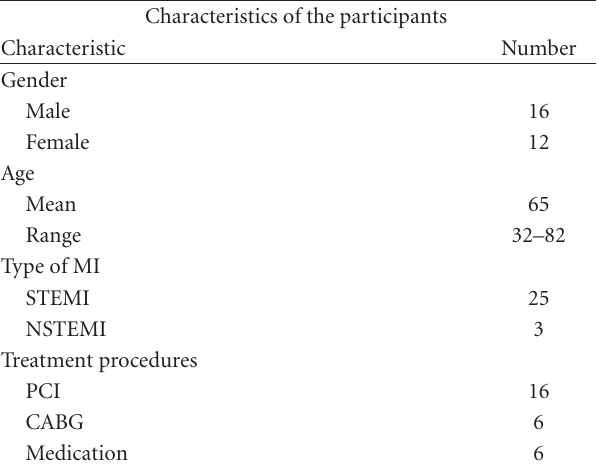
Table 1: Characteristics of the study